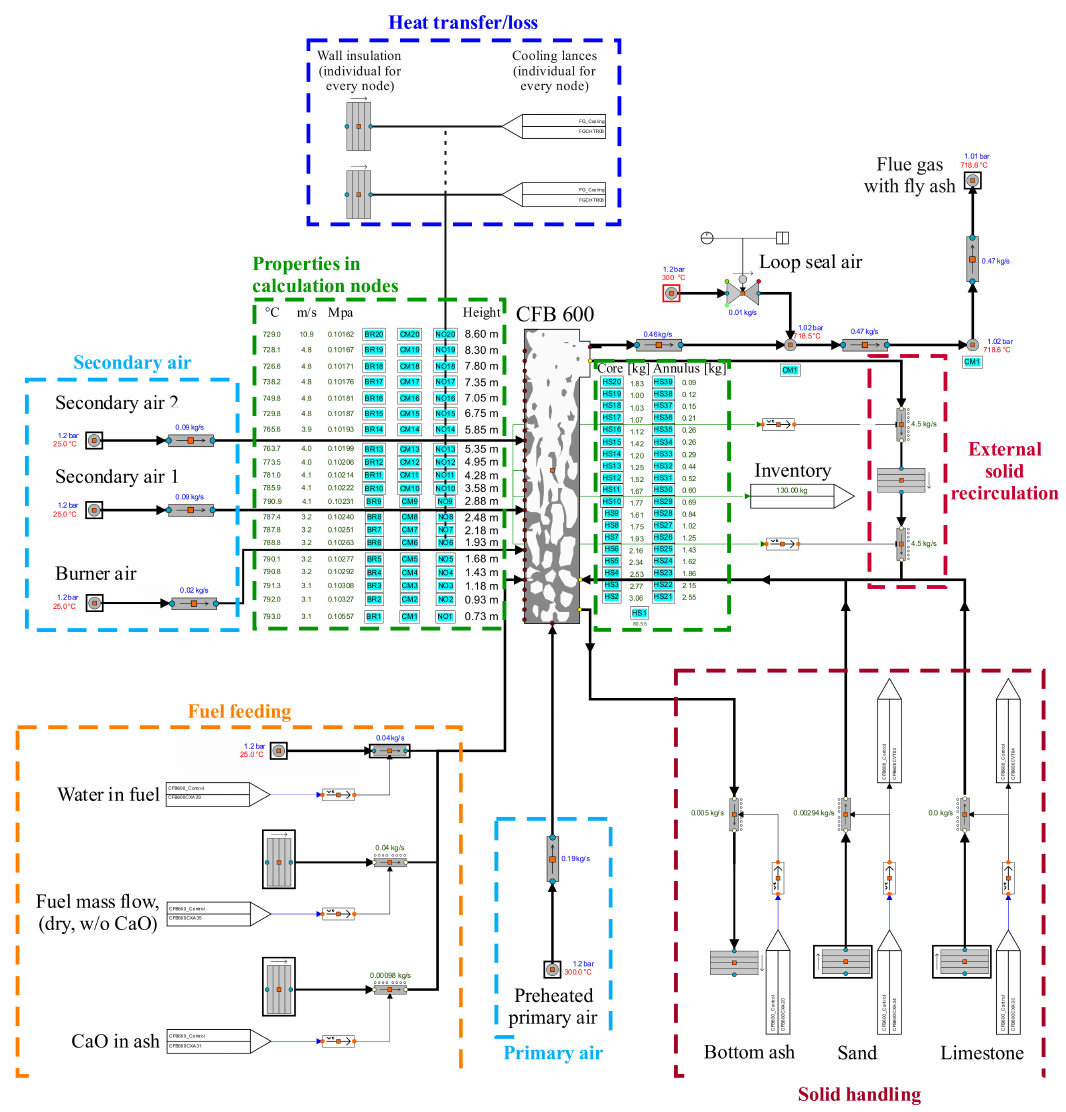
Figure 4. Circulating fluidized bed (CFB) combustor